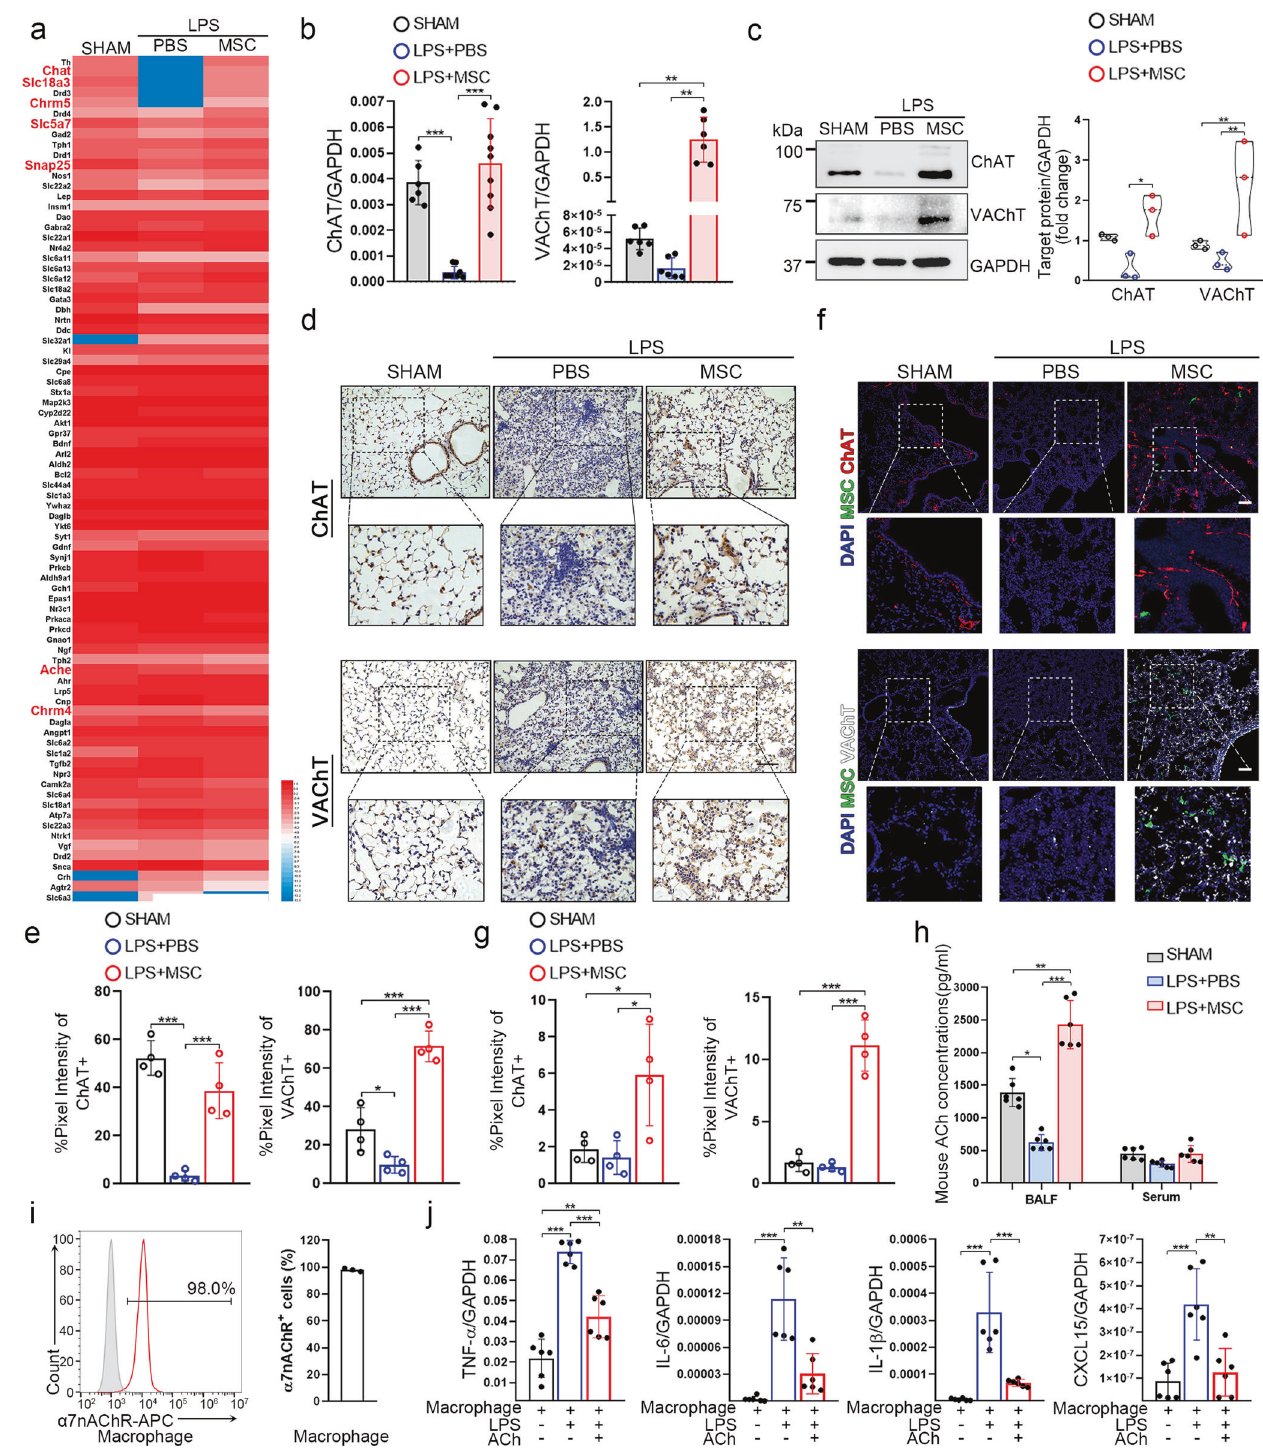
Fig. 2 MSCs facilitate the upregulation of choline ChAT and VAChT expression in injured lungs. a Heatmap showing neurotransmitter synthesis/transport-related genes expression levels in each group. Genes were ranked according to fold changes in expression between the PBS and MSC treatment group. The expression values of the genes were normalized to the Z score before the heatmap was generated; n = 3. Relative mRNA expression ( b ) and protein levels ( c ) of ChAT and VAChT in MSCs from each group. Representative immunohistochemical staining ( d ) and quanti fi cation ( e ) of ChAT (left) or VAChT (right) pixel intensity; scale bars, 100 μ m; n = 4. Representative confocal images ( f ) of lung sections from different groups stained for MSCs (green) and ChAT (red; upper) or VAChT (white; lower). DAPI staining showed the cell nuclei (blue). Scale bars, 100 μ m. Quanti fi cation ( g ) of the percentage of ChAT (left) or VAChT (right) pixel intensity; n = 4. h LC-MS/MS was used to detect BALF and serum ACh concentrations; n = 6. i Representative plots of α 7nAChR expression by macrophages; n = 3. j Relative mRNA expression of CXCL15, TNF- α , IL-1 β , and IL-6 in macrophages; LPS (10 μ g/ml) and/or ACh (1 mM) were used to stimulate macrophages. n = 6